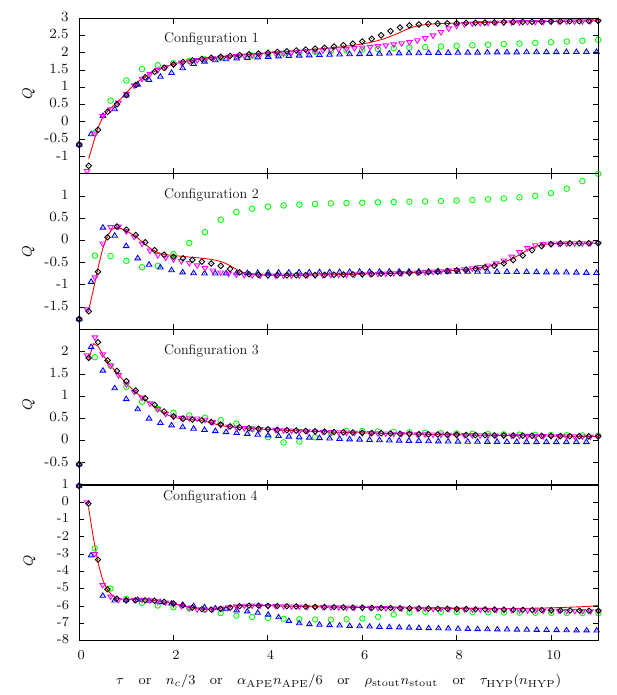
Fig. 5 For four different gauge field configurations, we show the clover definition of the topological charge as a function of the gra- dient flow time τ for Wilson flow (line in red), n c / 3 for cooling ( ◦ ), 0 . 5 × n APE / 6 for APE smearing ( (cid:2) ), 0 . 05 × n stout for stout smearing ( (cid:21) ) and τ HYP ( n HYP )) for HYP smearing ( (cid:22) ). For this ensemble t 0 (cid:19) 2 . 5 a 2